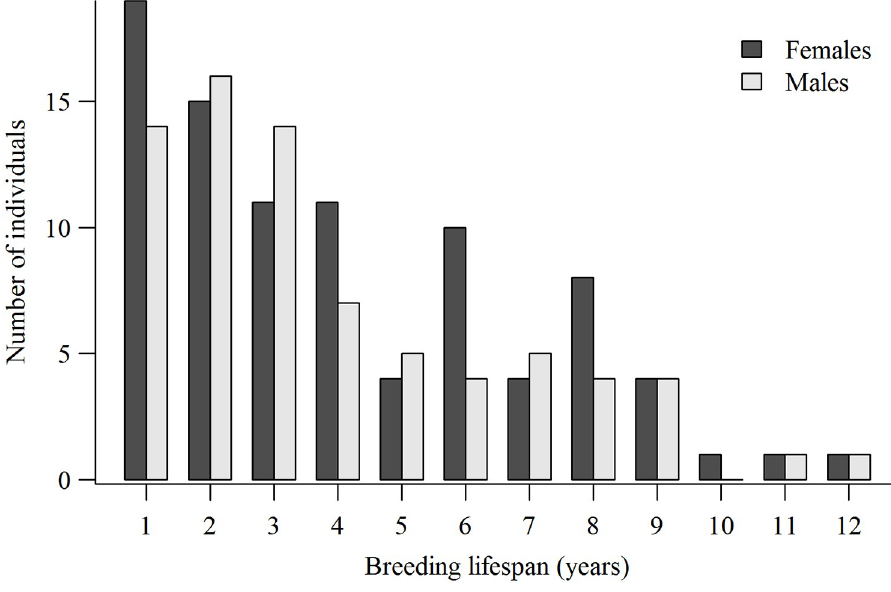
Fig 2. Breeding lifespans (years from first to last breeding) of 75 males and 89 females of combined known-age and � 4-year-old goshawks first breeding in the 1992–2000 cohorts in Arizona, USA.